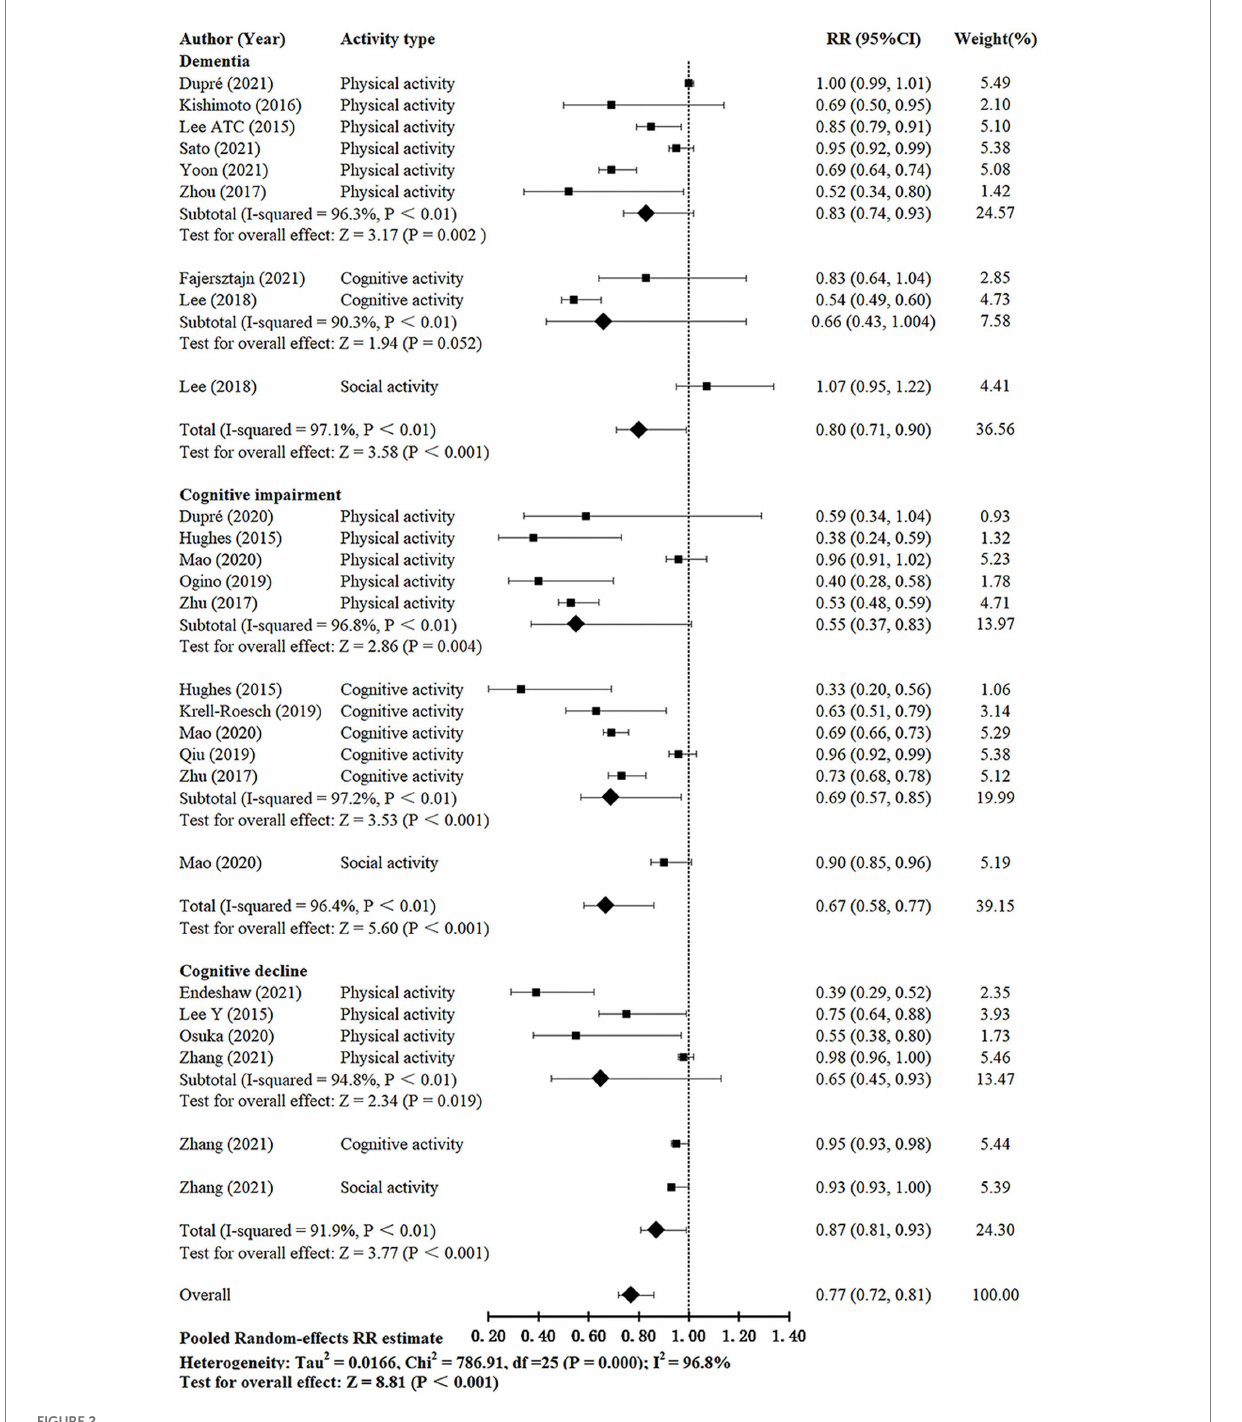
FIGURE 2 Meta-analysis of the relationship between leisure activity and cognitive function in older